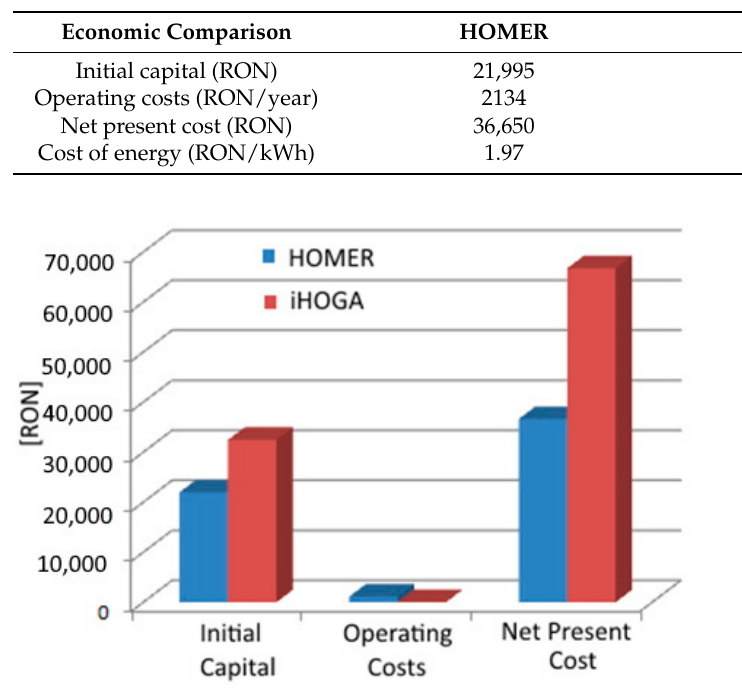
Figure 19. Economical comparison of the two simulators.